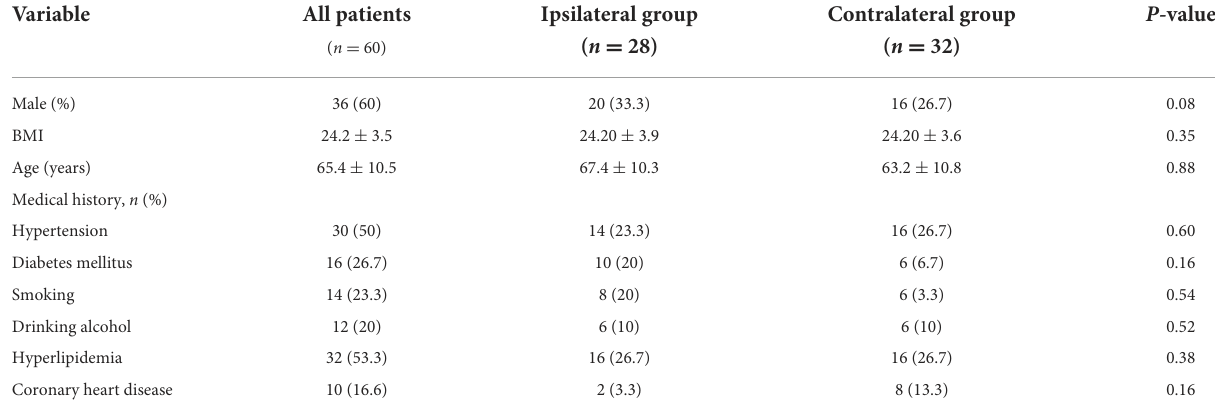
TABLE 1 Baseline characteristics of all ESUS patients [ x ± s or n (%)].